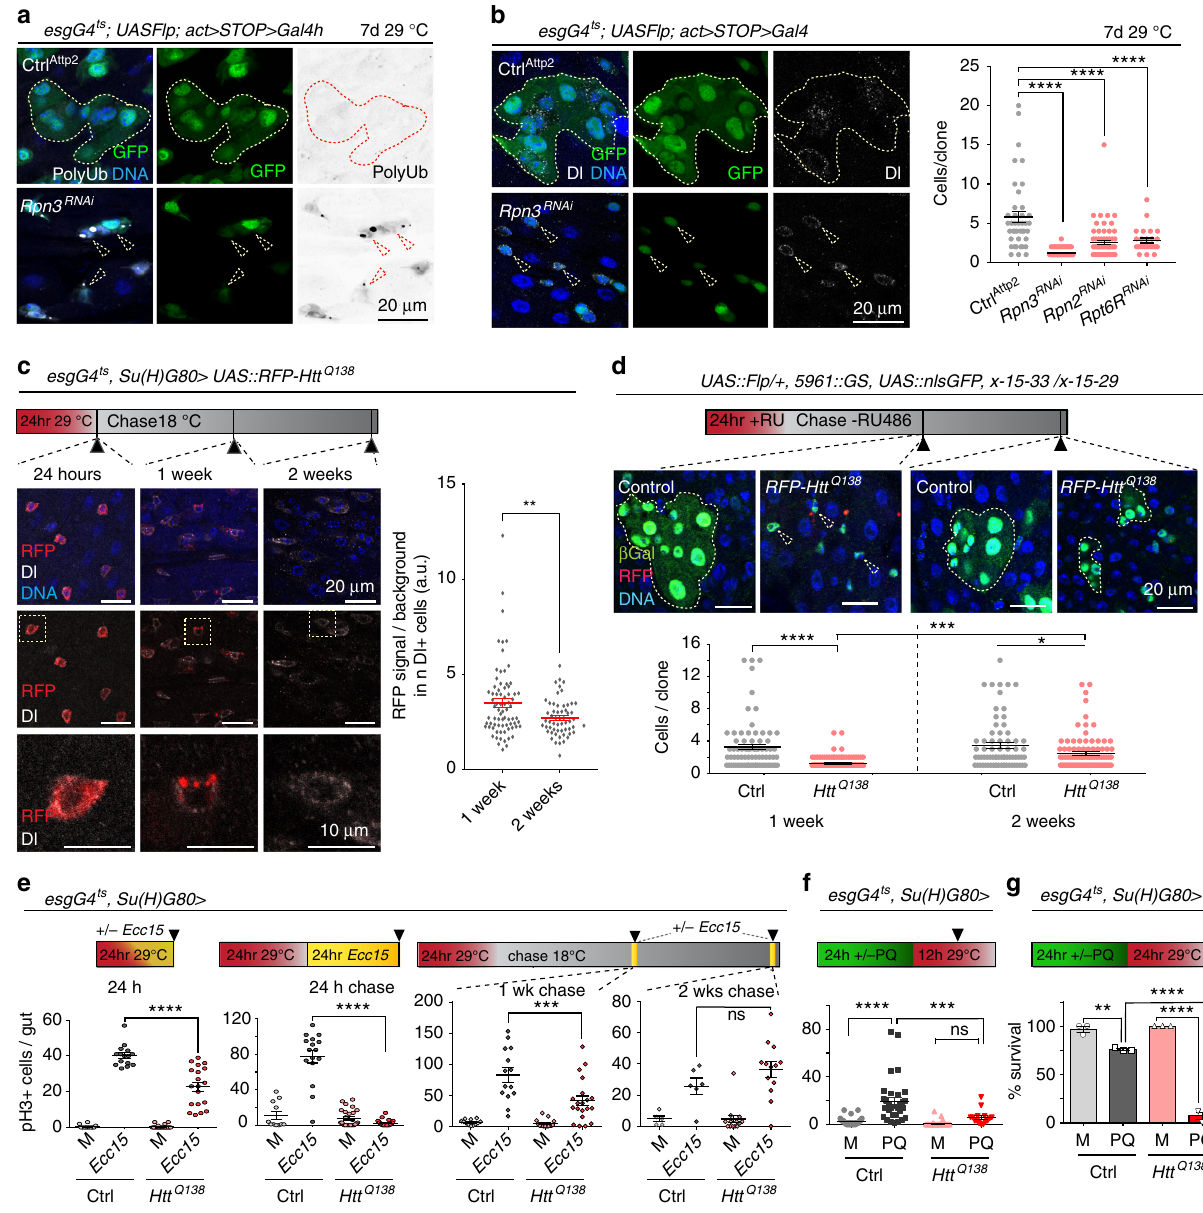
Fig. 1 Protein aggregates induce a transient cell cycle arrest in ISCs. a , b GFP-marked lineages (green) from Rpn3 RNAi expressing ISCs in 8-day-old fl ies. Immunohistochemistry: a anti-poly-ubiquitin (white, left; black, right), b anti-Delta (white). b 1-way ANOVA / Dunnett ’ s ( n = 41, 73, 66, and 25 clones from 3, 4, 4, 3 independent animals respectively). c mRFP-Htt Q138 expressed for 24 h in ISCs of 11-day-old fl ies. Delta (Dl; white). Graph: RFP signal normalized to background. Two-tailed unpaired t-test: ( n = 75 and 57 Dl + cells from fi ve and three animals respectively, from two independent experiments). d ISC lineages from 4 days old fl ies labelled with β -galactosidase ( β gal, green) using Flp-mediated somatic recombination of a split lacZ gene (X-15-33/x-15-29 47 ), carrying or not mRFP-Htt Q138 (RU486-inducible ISC/EB driver 5961::GS). Beta-galactosidase (green), RFP-labeled aggregates red. Yellow arrowheads point out β gal-labeled ISCs. 1-way ANOVA/Sidak ’ s ( n = 76, 154, 72, and 97 clones from 10, 13, 9, and 9 animals respectively, from two independent experiments). a – d , Representative areas of posterior midgut. DNA (Hoechst, blue); scale bars 20 µ m and 10 µ m ( c , inset). e Quanti fi cation of phospho-Histone H3 (pH3) + cells after 24 h expression of mRFP-Htt Q138 in ISCs of 6 to 8-day-old fl ies during infection with Ecc15 (or Mock, M; fi rst graph), or followed by 24 h Ecc15 immediately (second graph), or by 8 h Ecc15 one week (third graph), or two weeks (fourth graph) later. Two-way ANOVA with Tukey ’ s ( n = 12, 15, 20, 19 guts ( fi rst); 11, 16, 26, 24 guts (second); 12, 14, 19, 20 guts (third); 5, 6, 13, 13 guts (fourth graph)). f pH3 + cell quanti fi cation in 12-day-old fl ies after 5 mM Paraquat (PQ) or Mock (M) treatment at 25 °C, followed by regular food at 29 °C for 12 h. Two-way ANOVA with Sidak ’ s ( n = 32, 32, 40, 15 guts, from two independent experiments). g Survival of 12-day-old fl ies fed 5 mM PQ or Mock at 25 °C for 24 h, followed by regular food at 29 °C for 24 h ( n = 3 biological replicates). Two-way ANOVA with Tukey ’ s. Means and s.e.m. shown in all graphs; ns, not signi fi cant, **** P < 0.0001, *** P < 0.001, ** P < 0.01, * P < 0.05. Genotypes in Supplementary Table 1